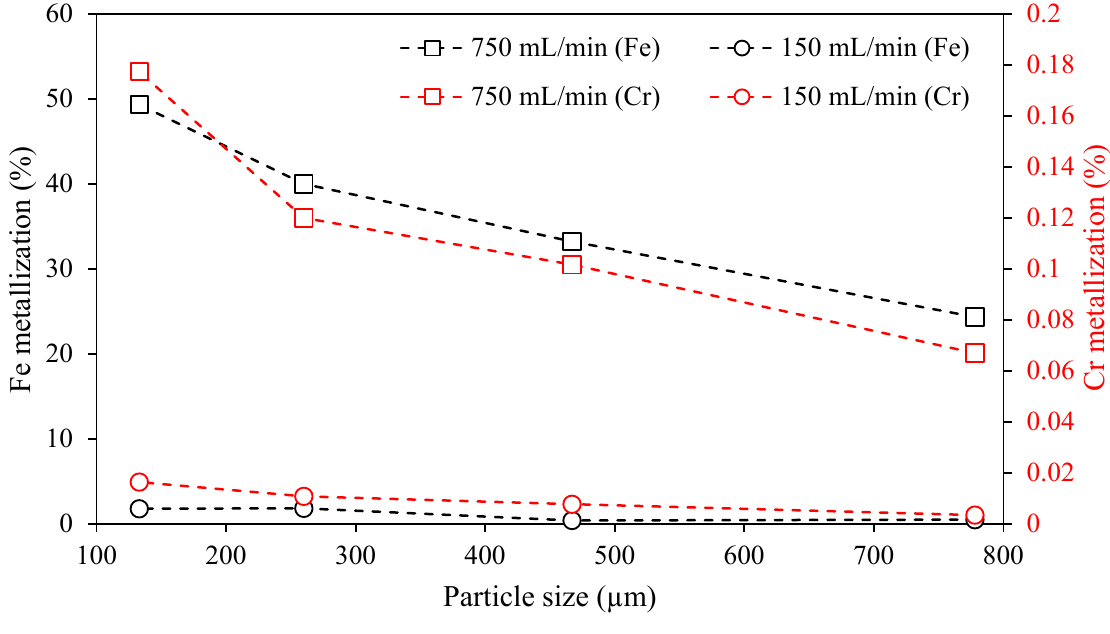
Figure 2. The effect of hydrogen flow rate on Fe and Cr metallization. Size-fractioned samples (d 90 of 133 to 778 µm) were reduced at 1100 °C for 60 min.